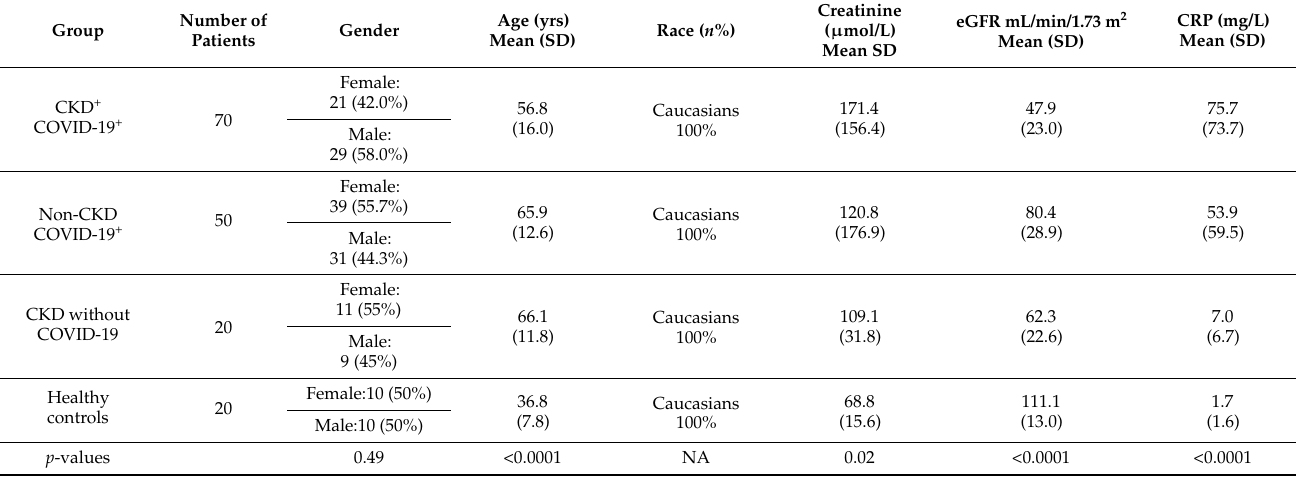
Table 1. Population description.